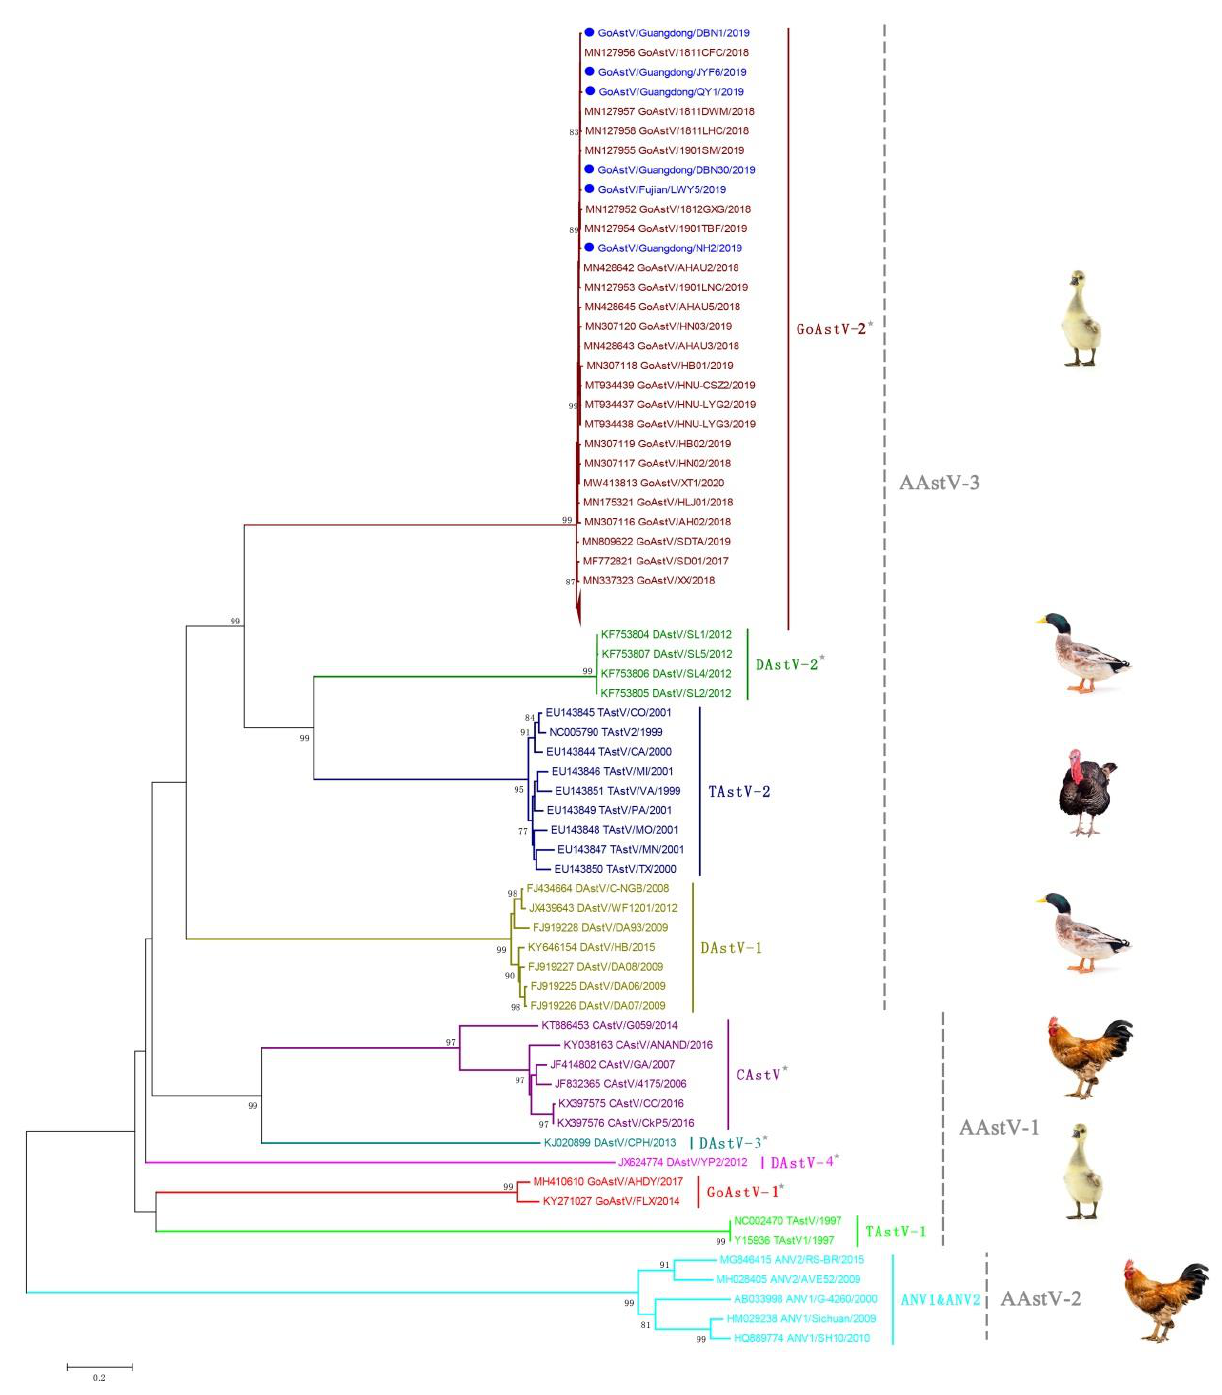
Figure 2. Phylogenetic analysis of the GoAstV with other astroviruses constructed based on the complete genome. The tree was constructed with the neighbor-joining method with 1000 bootstrap replicates in MEGA 5.0 after multiple sequence alignments by MAFFT. The strains shown in blue with solid blue circles were identified in this study, and proposed species yet to be recognized are designated with